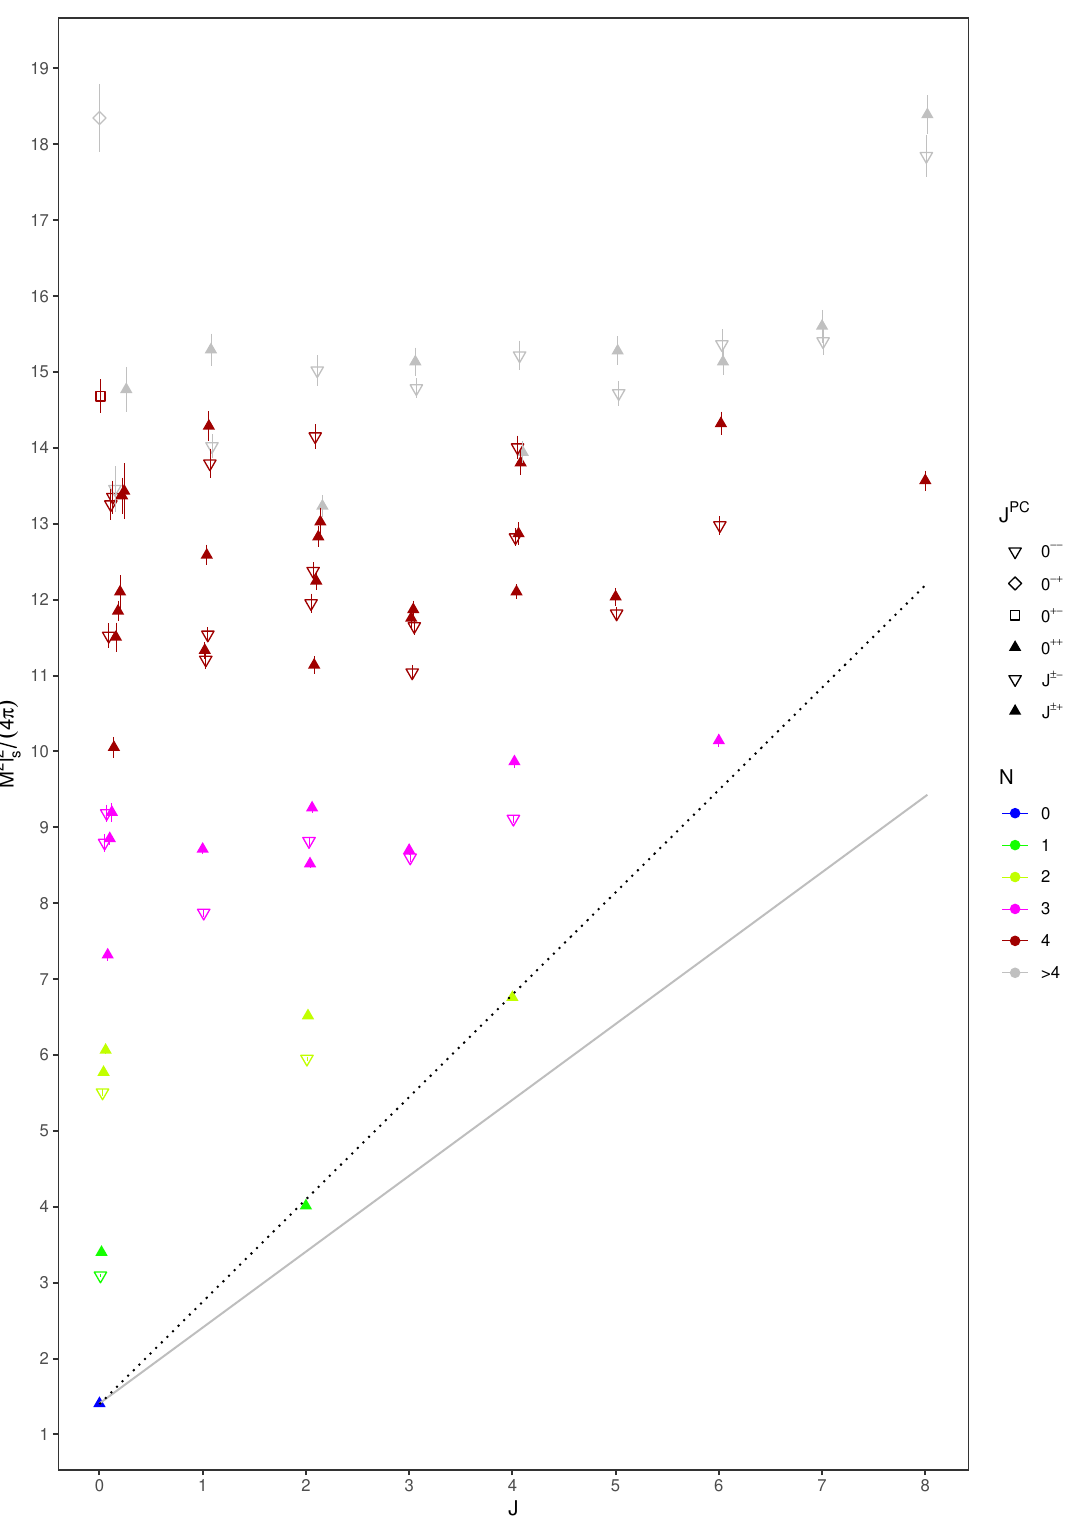
Figure 11. The Chew-Frautschi plot with color coded level assignment up to N = 4.